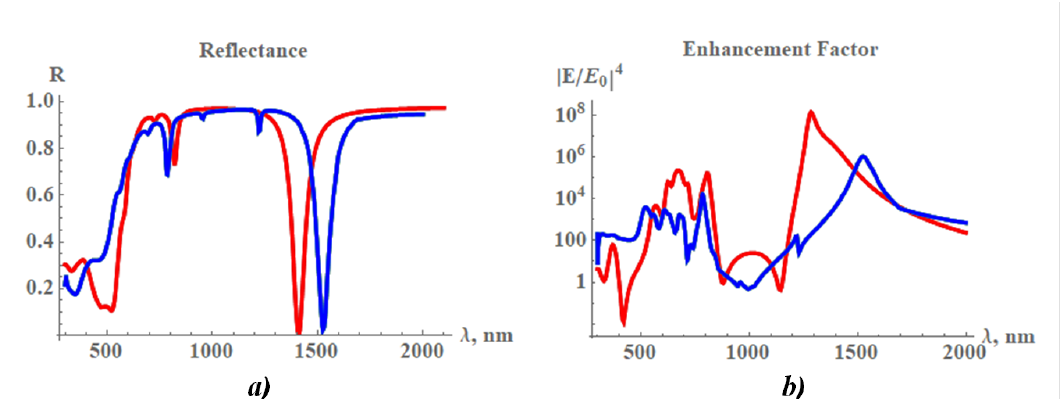
Figure 2. Results of analytical model (red) and COMSOL computer simulations (blue) of the system shown in Figure 1, disk diameter D = 2 a = 130 nm, period of square lattice P = 300 nm, thicknesses of the upper gold plate and silicon interlayer are 20 nm, gold film has thickness of 40 nm. ( a ) Reflectance from surface-enhanced Raman scattering (SERS) substrates and ( b ) electric field enhancement factor (EF) averaged over the lateral side of the plasmon resonator EF = (cid:104)| E / E 0 | 4 (cid:105) , where E 0 corresponds to the amplitude of the incident EM